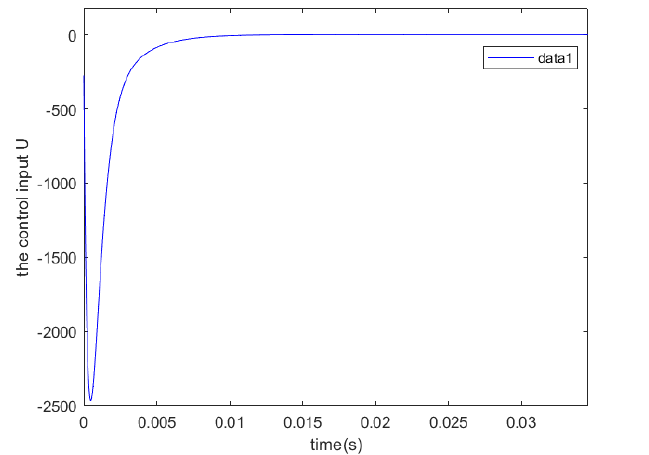
Figure 3. Control law evolution with gains obtained via Theorem